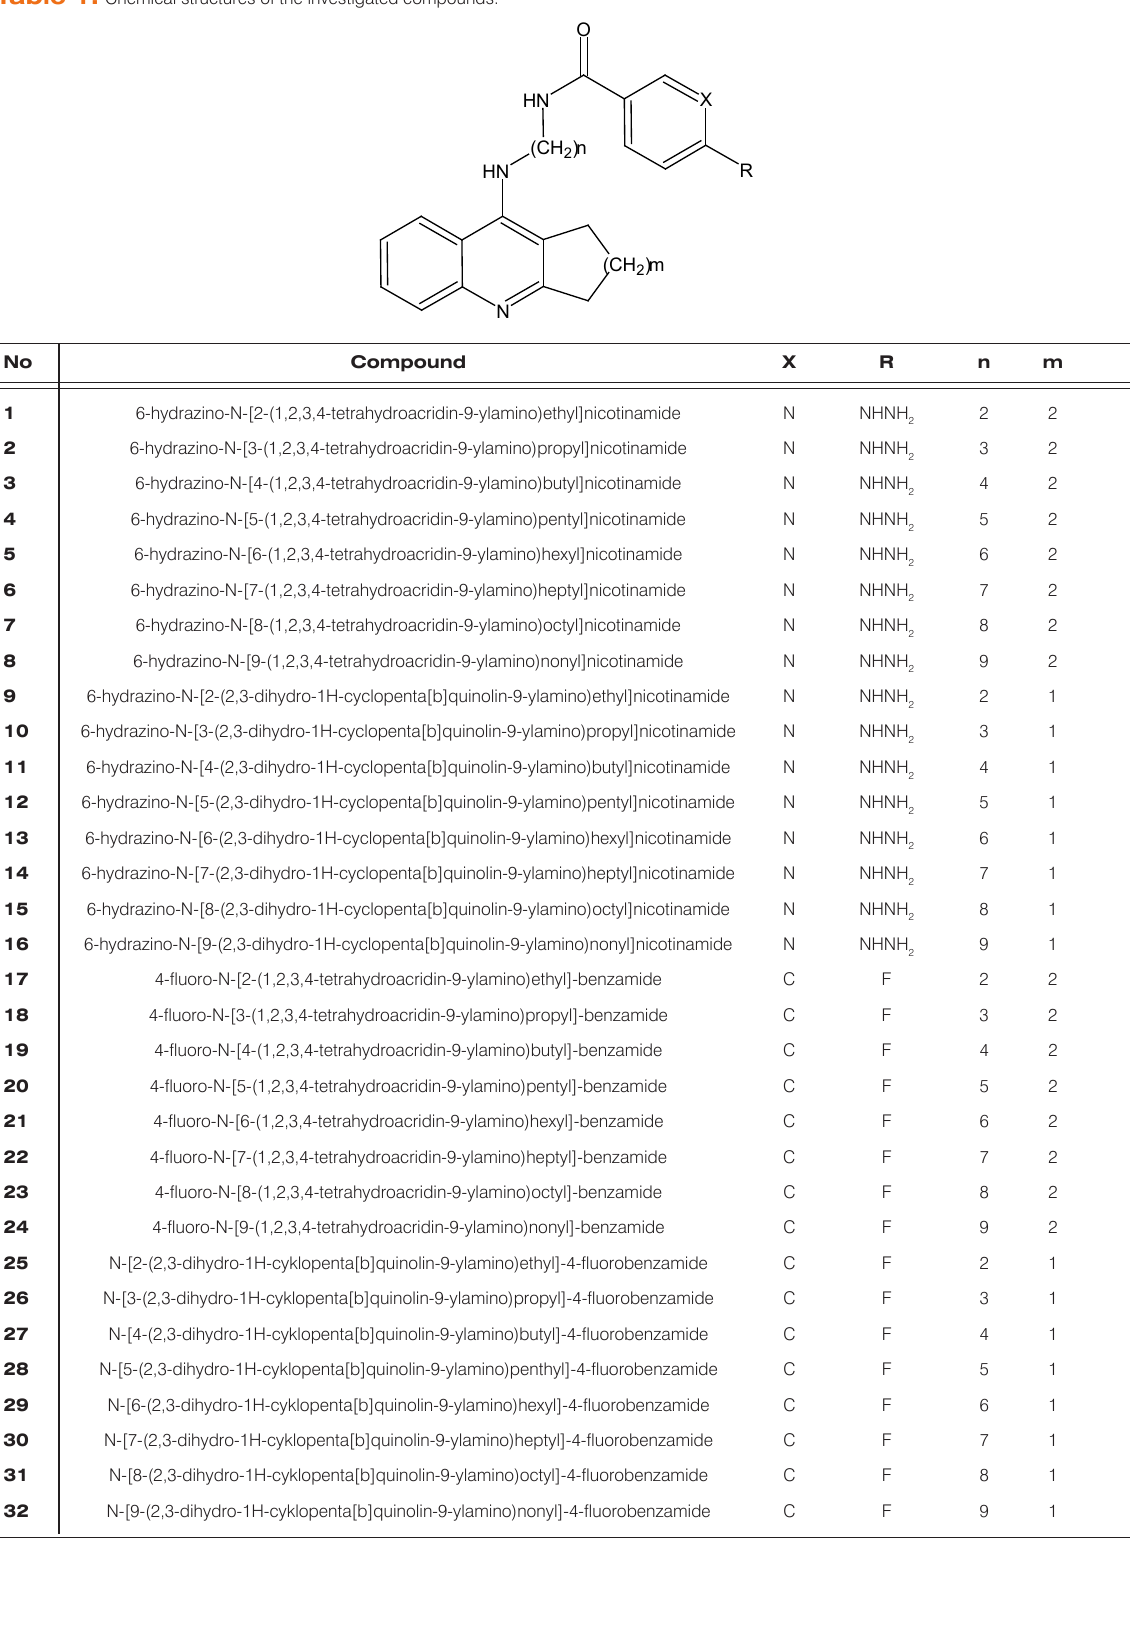
Table 1. Chemical structures of the investigated